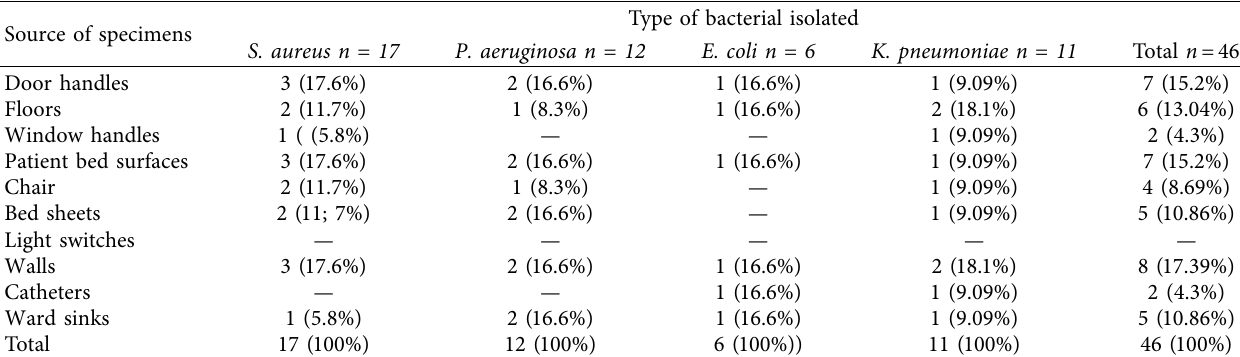
Type of bacterial